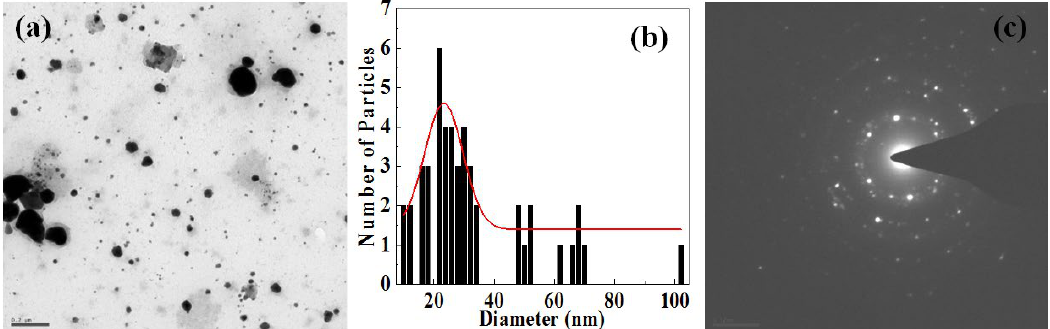
Fig. 2. (a) TEM image of Au-Ag ANPs (Au50Ag50) (b) Histogram for the Au-Ag ANPs (c) SEAD pattern of Au-Ag